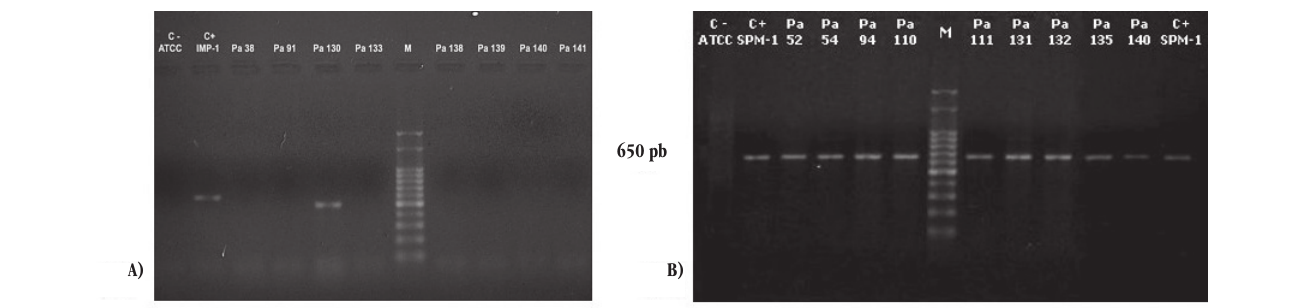
figuRE − PCR products ( bla genes) in Pseudomonas aeruginosa strains. The negative control (C-) is the P. aeruginosa ATCC 27853; P. aeruginosa positive for the presence of bla IMP or bla SPM is